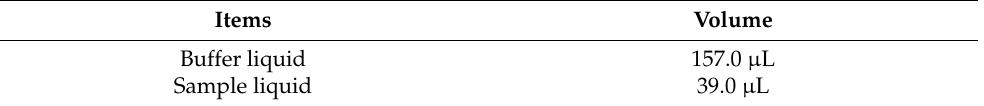
Figure 2. Grid cutting and boundary conditions in the pattern of the disc. ( a ) Mesh cutting of the disc runner structure. ( b ) Boundary condition set on the buffer and sample chamber. Table 1. Illustration of the volume design for the buffer liquid and sample liquid.